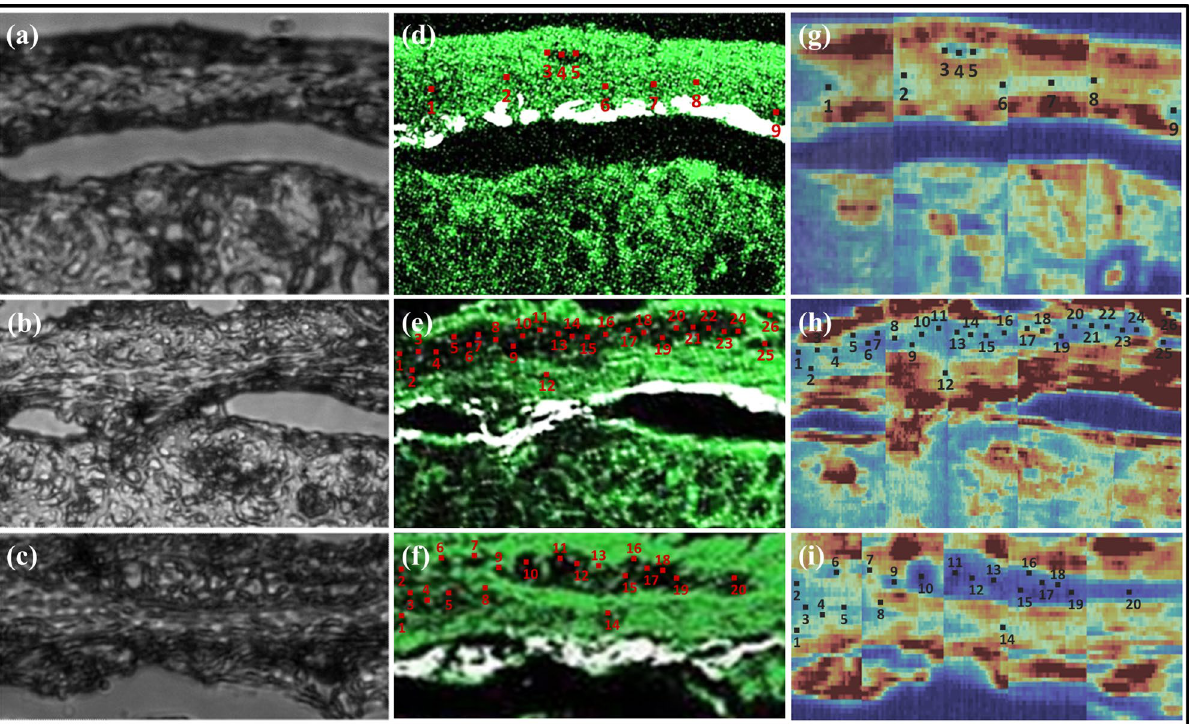
Figure 8. ( a – c ) Brightfield images from unstained section and their correspondent label-free images: ( d – f ) SHG and 2PAF overlaid signals; ( g – i ) Raman map by using the 1450 cm −1 average values. Figure 6b shows the coefficient plot of the first three PCs and highlights some Raman peaks that contribute most in discriminating the groups: 741, 770, 794, 837, 877, 901, 859, 1001, 1087, 1447, 1676 cm −1 . We noticed that the ratio intensity between the 1447 and 1676 cm −1 peaks, assigned to lipids and proteins are very relevant in the discrimination. Also, compared to muscle layer, spectra from the ganglion cells have stronger peaks associated with nucleic acids (741 and 794 and 1087 cm −1 ) and lipids (770, 837 and 877 cm −1 ), which is in agreement with previous study 23 . A 3-D plot of the covariance error ellipsoids with 90% interval confidence, which determines the boundaries of the PCA-LDA prediction model, is shown in Fig. 6c. The accuracy of the prediction model, 95%, was quantified in the confusion matrix (Fig. 6d) with 86% sensitivity and 99% specificity. Raman fingerprints of the connective submucosa (n = 166) and the mucosa layers (n = 281) were also acquired. Figure 7a shows the average Raman spectra of each group. As expected, the submucosa region, which emit strong SHG signals due to the presence of collagen, exhibit strong Raman signals at 923, 938, 1056, 1235, 1286, 1309 and 1332 cm −1 , all known Raman peaks associated with collagen 24 . Figure 7b,c shows the discrimination of all 4 groups together, with an overall accuracy of 96%. All of the misclassified ganglion cell spectra were assigned to the muscularis group, which is not surprising considering the close proximity of these two regions to each other. To mimic a more realistic diagnostic scenario, we performed blinded experiments on unstained tissue sec- tions without prior knowledge of whether they contained ganglion cells. That determination was based solely on the label-free imaging results, which were then compared to H&E stained adjacent tissue sections at the end of the experiment. Figure 8 shows brightfield images of three unstained colon sections and their corresponding SHG/2PAF and hyperspectral Raman images. Using the SHG signal from the connective submucosa layer as an initial guide, the muscularis layer (above the SHG line) and the mucosa (below the SHG line) are identified. Within the muscularis layer, regions of negative 2PAF contrast that are potentially ganglion cells are located. Raman fingerprints were collected from these regions and adjacent regions above the connective submucosa layer, as depicted by the numbered locations in Fig. 8. PCA was then performed on this data set and the results were plotted on the PCA-LDA plot and classification model defined by the previous reference dataset (from Fig. 7). Figure 9 shows the PCA-LDA plot and the corresponding H&E images with yellow arrows highlighting the ganglion cells, as determined by a pathologist, and numbered locations corresponding to the positions where